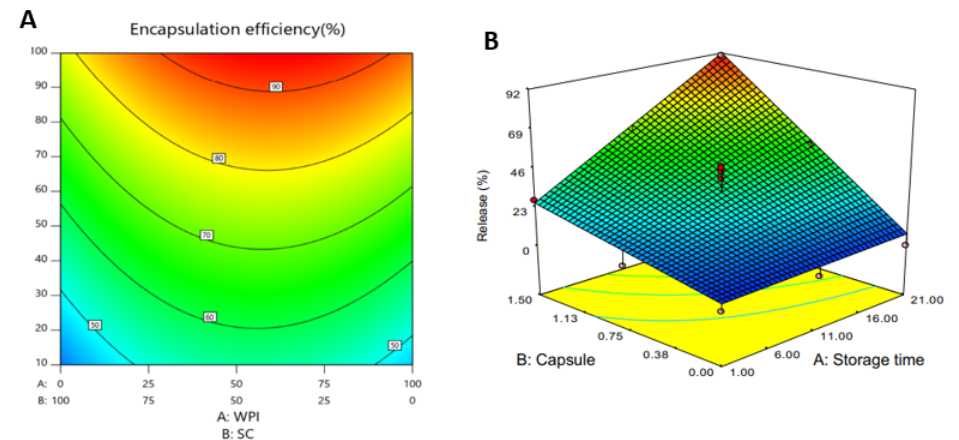
Figure 2. ( A ) Contour plots of encapsulation efficiency against sodium caseinate/isolated whey protein, ultrasound power and core to wall ration and ( B ) Three-dimensional curve of effect of storage time and microcapsule content in yoghurt on release rate of essential oil from microcapsules. Reproduced from [108] with permission from John Wiley and Sons, 2022.